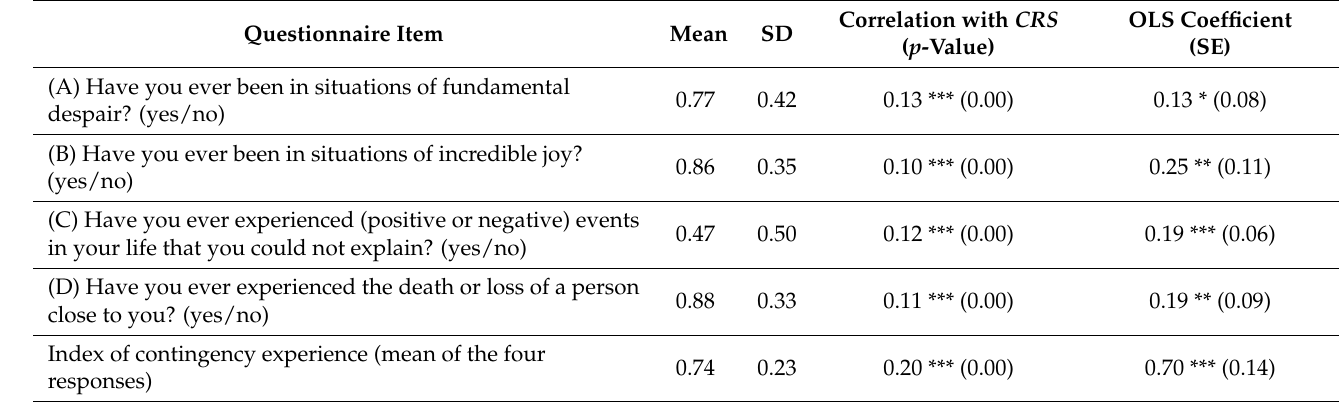
Table 4. Contingency